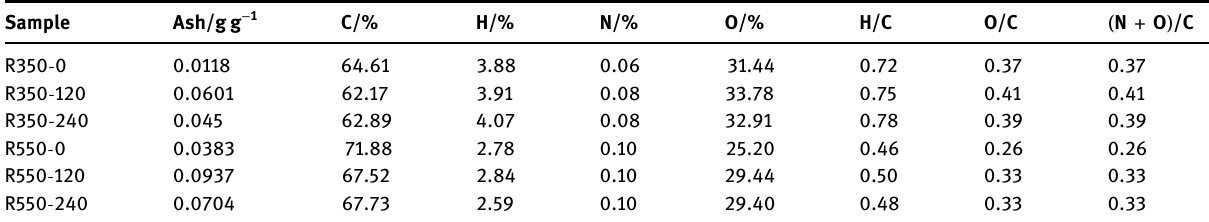
Table 1: Elemental compositions and chemical characteristics of R350 and R550 biochar during ageing in soil for 0 – 240 d